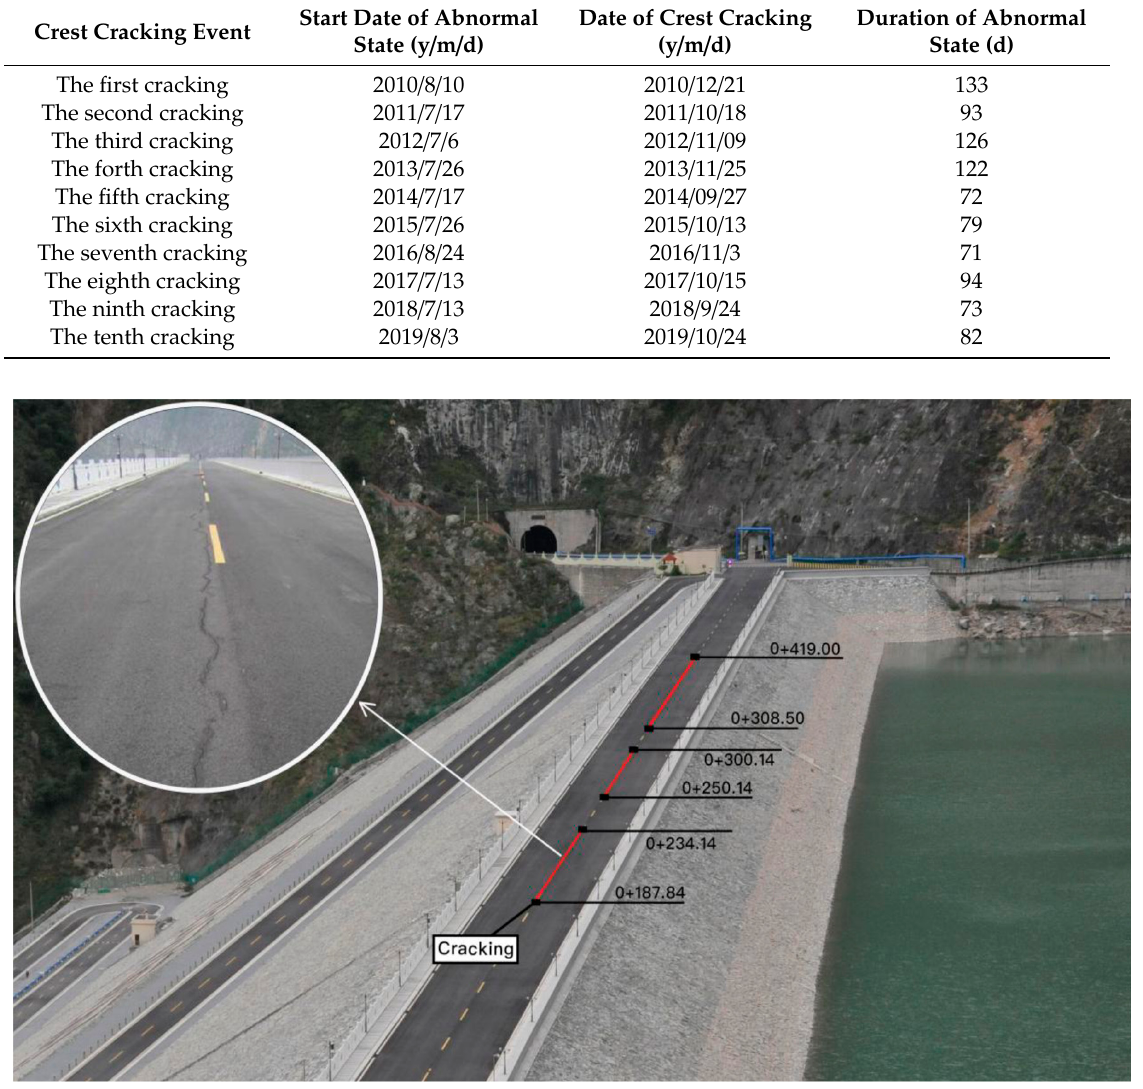
Figure 4. The revealed cracks in exploratory pits.